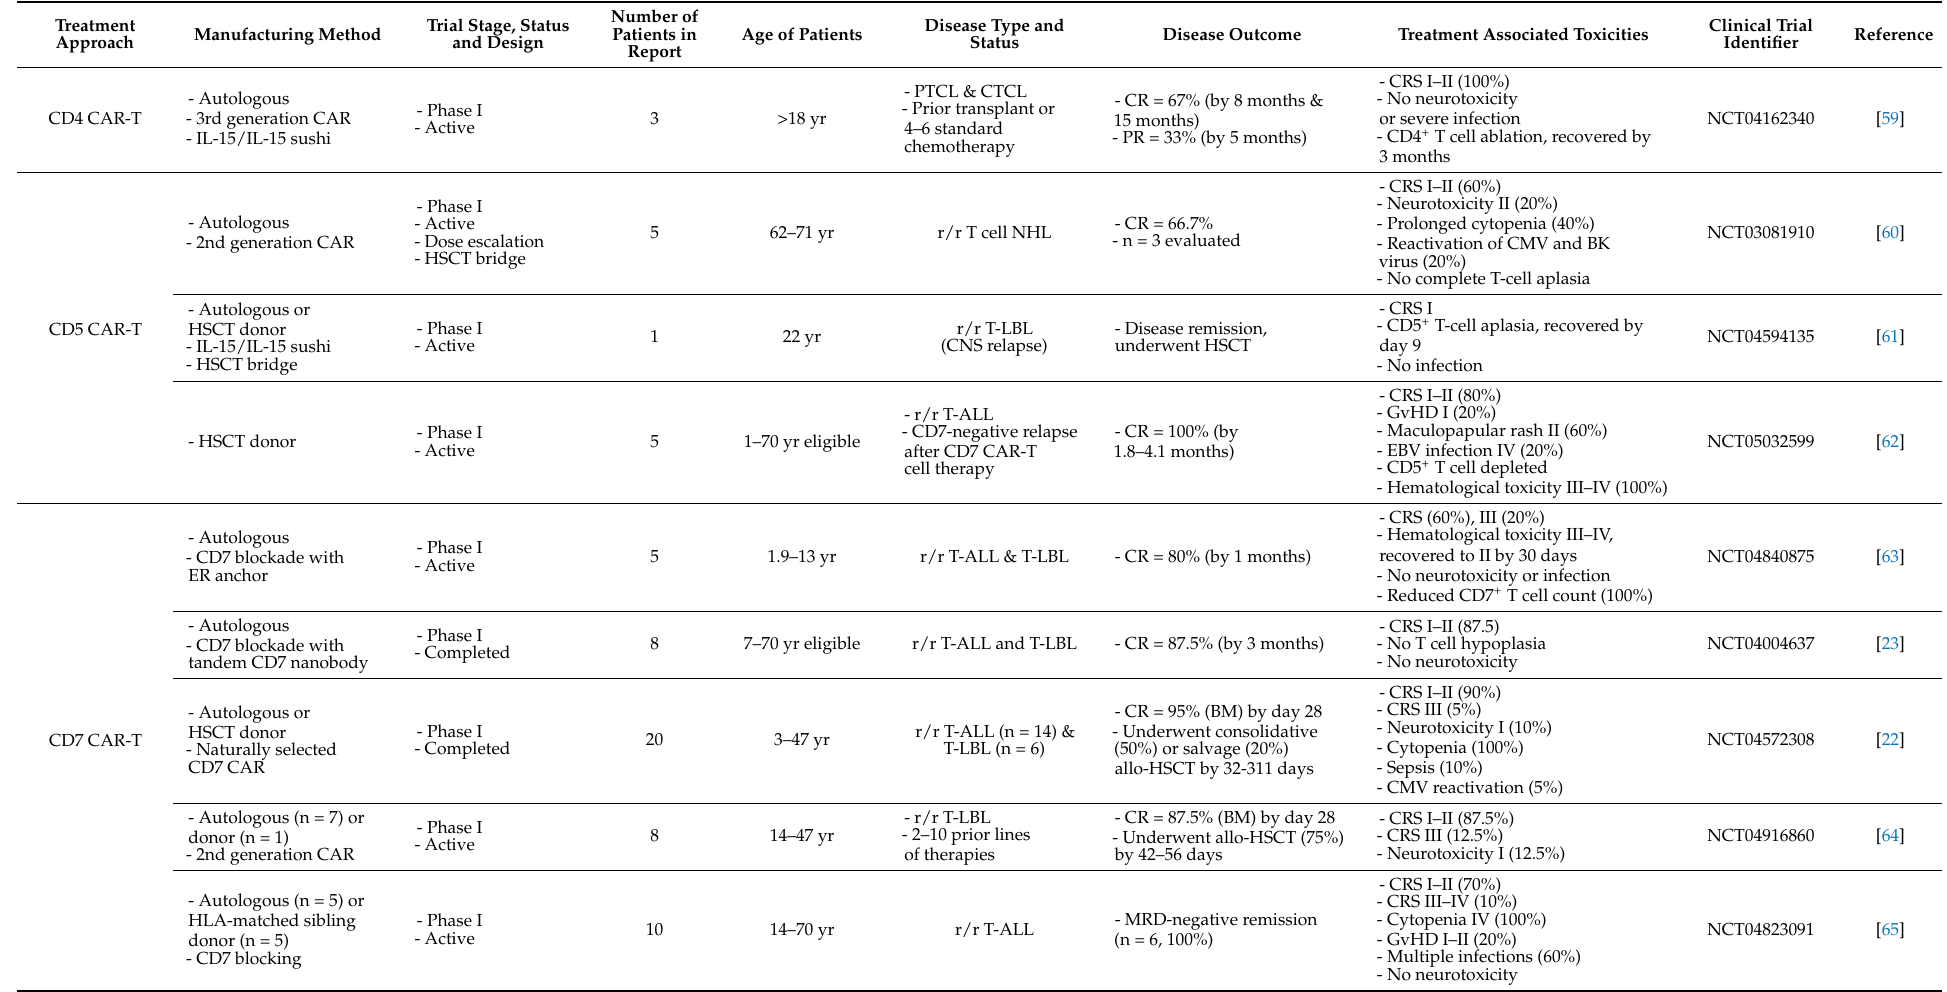
Table 3. Results from clinical trials of CAR-T cell therapy for T-cell